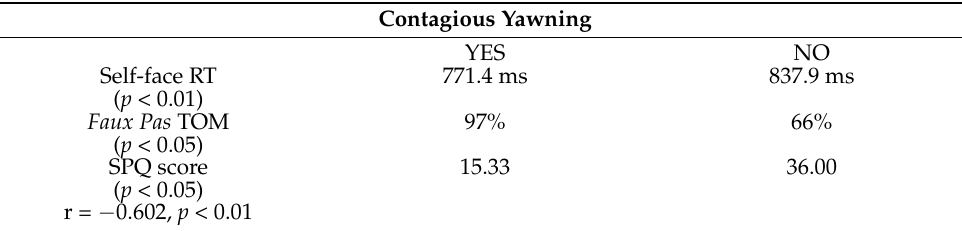
Table 2. Effects of SPQ on self-face reaction time, faux pas theory of mind stories, and susceptibility to contagious yawning.